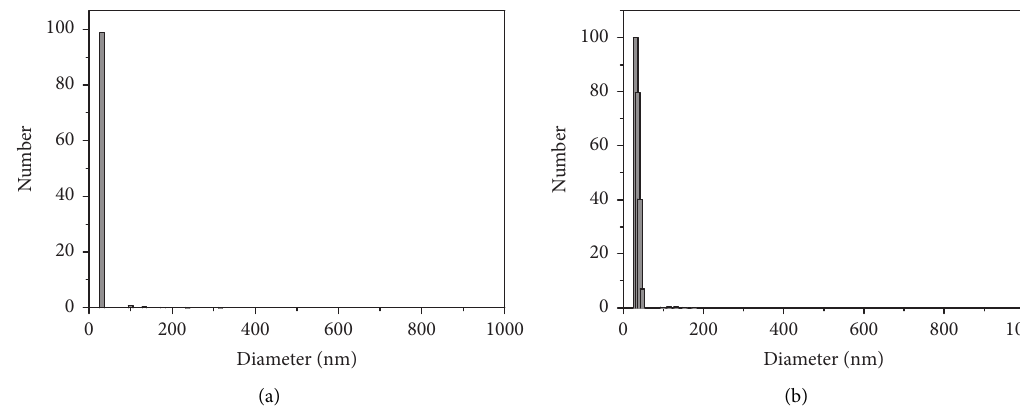
Figure 2: Hydrodynamic radius distribution of P4 (a) and P4 ′ (b) in water at [RU] � 1 μ